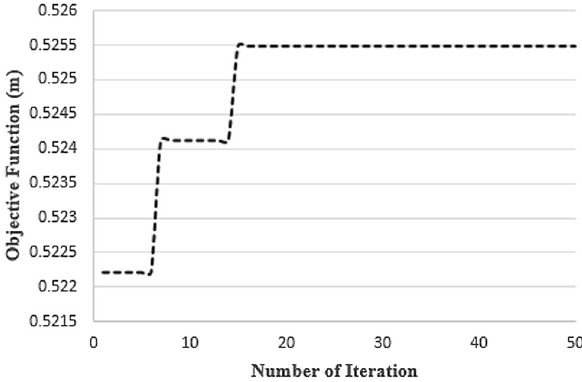
Table 5 Average of water table rising in each injection well